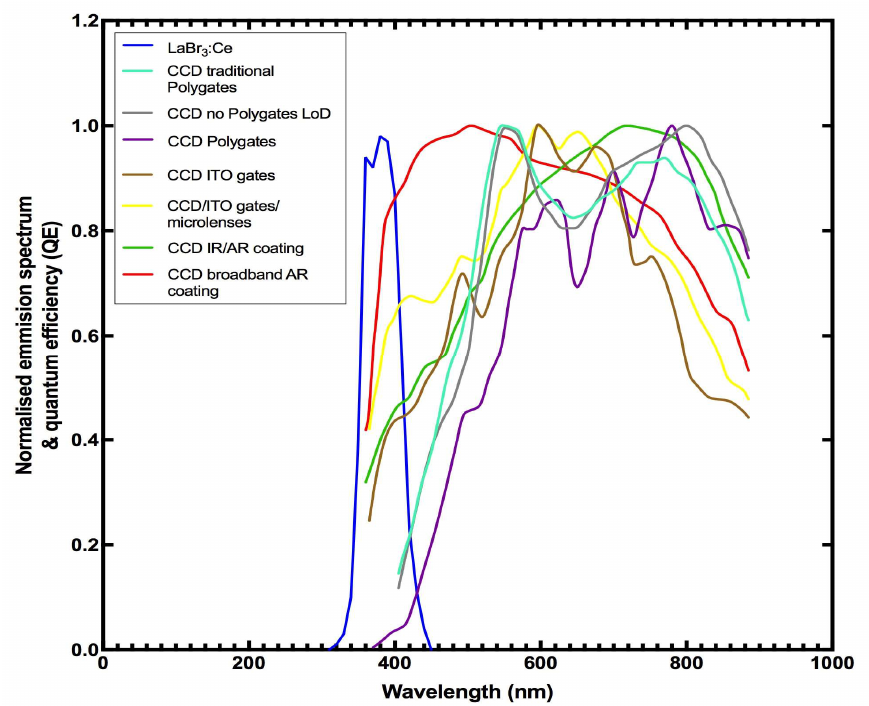
Figure 7. Optical spectral distribution of LaBr 3 :Ce crystal, and spectral sensitivity of CCD photoreceptors.